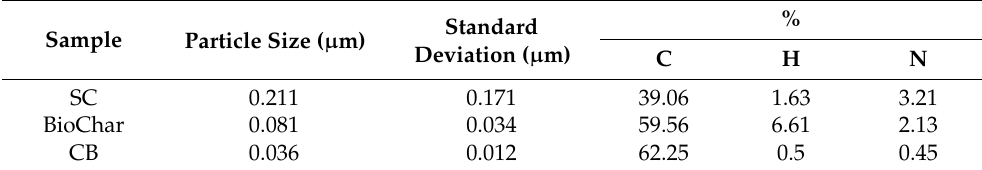
Table 2. Particle size analysis and elemental analysis results of the fillers.